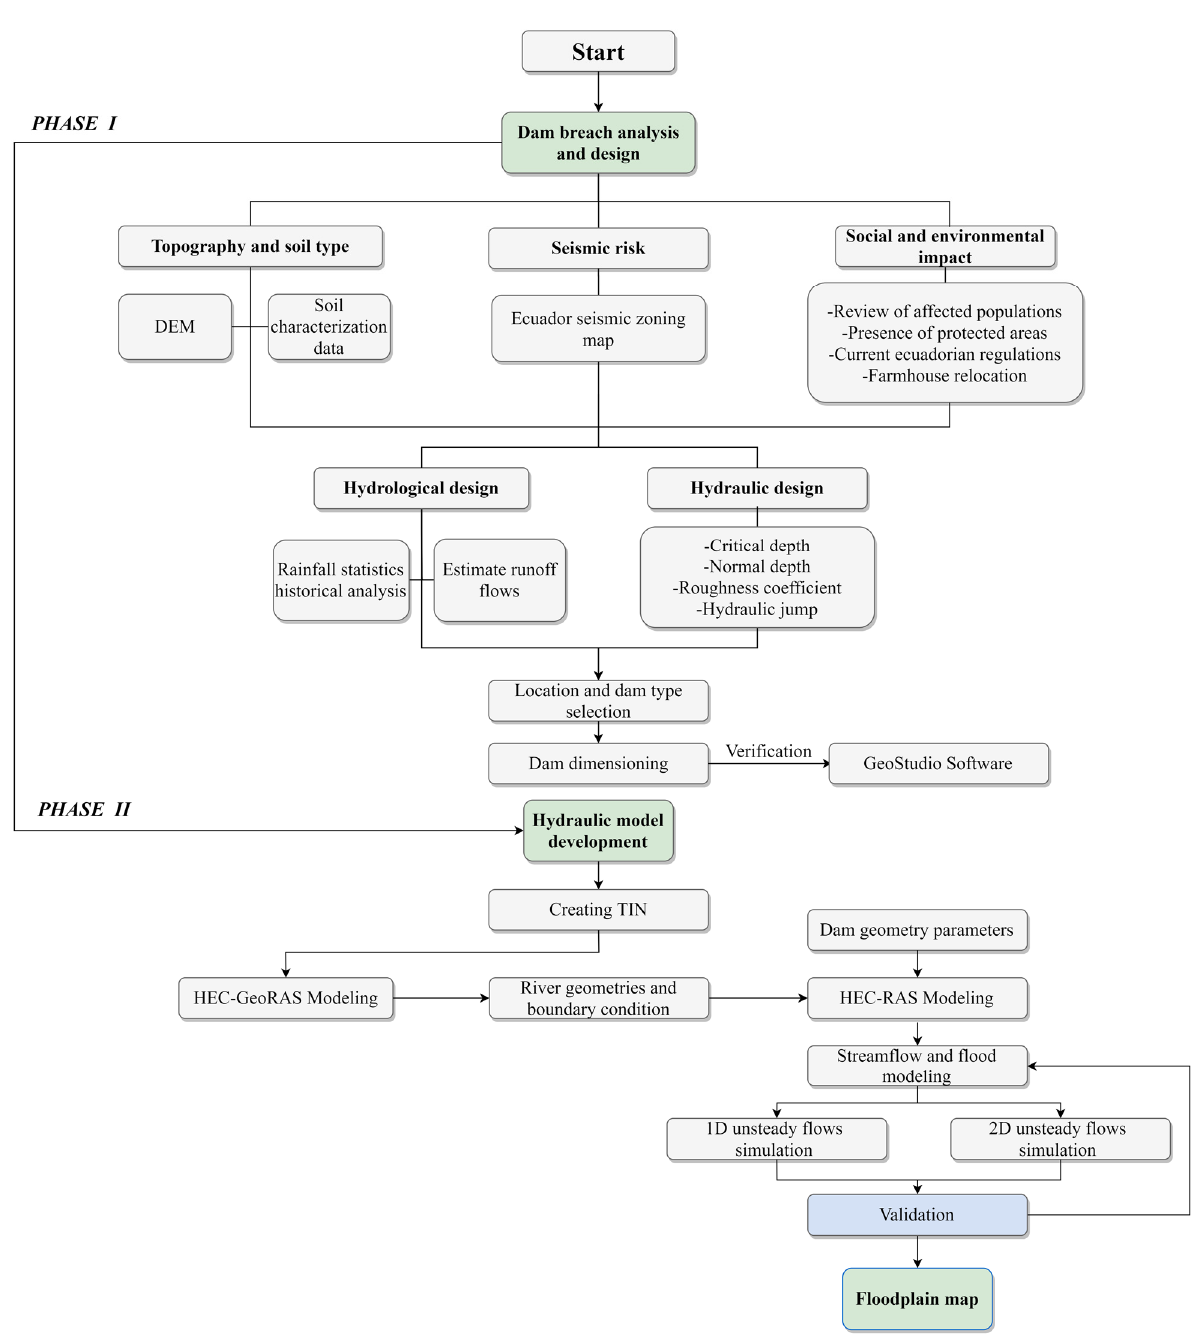
Figure 2. Scheme of the methodology followed in this